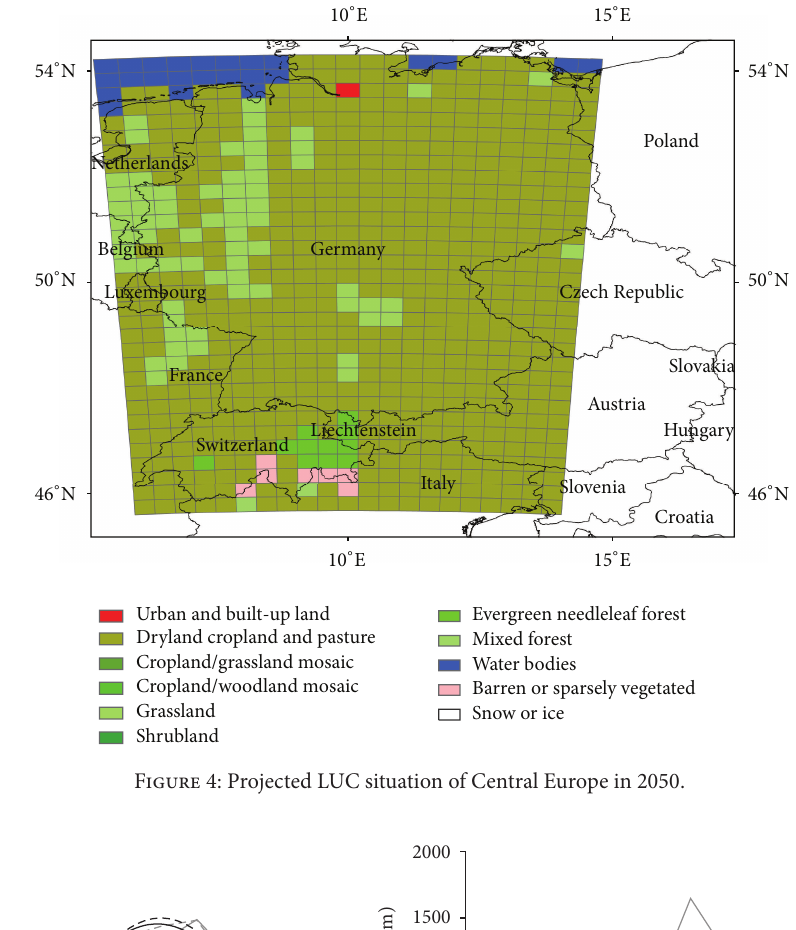
Figure 4: Projected LUC situation of Central Europe in 2050.